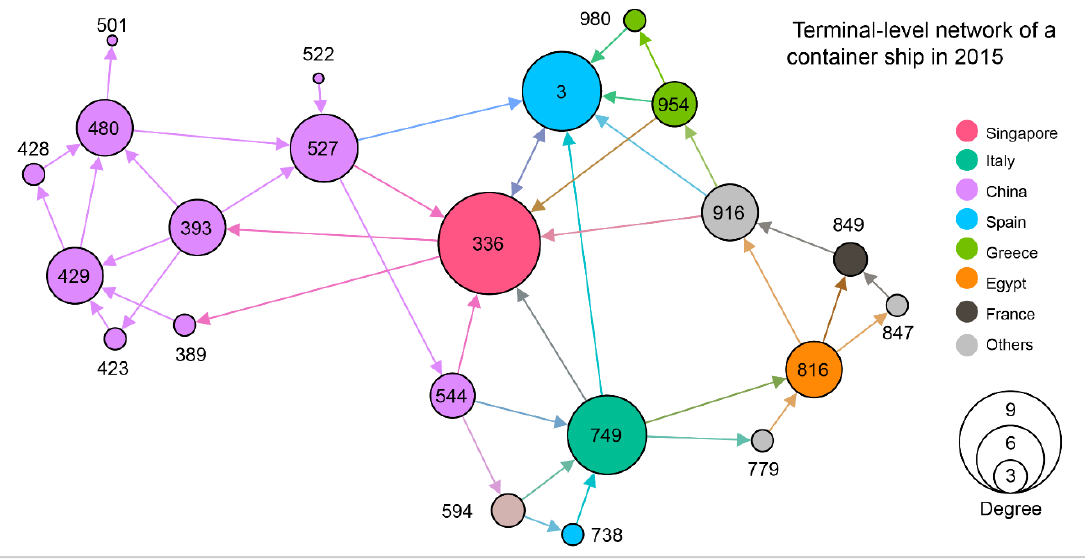
Figure 7. Terminal-level network of a container ship with 22 nodes located in 11 countries in 2015.